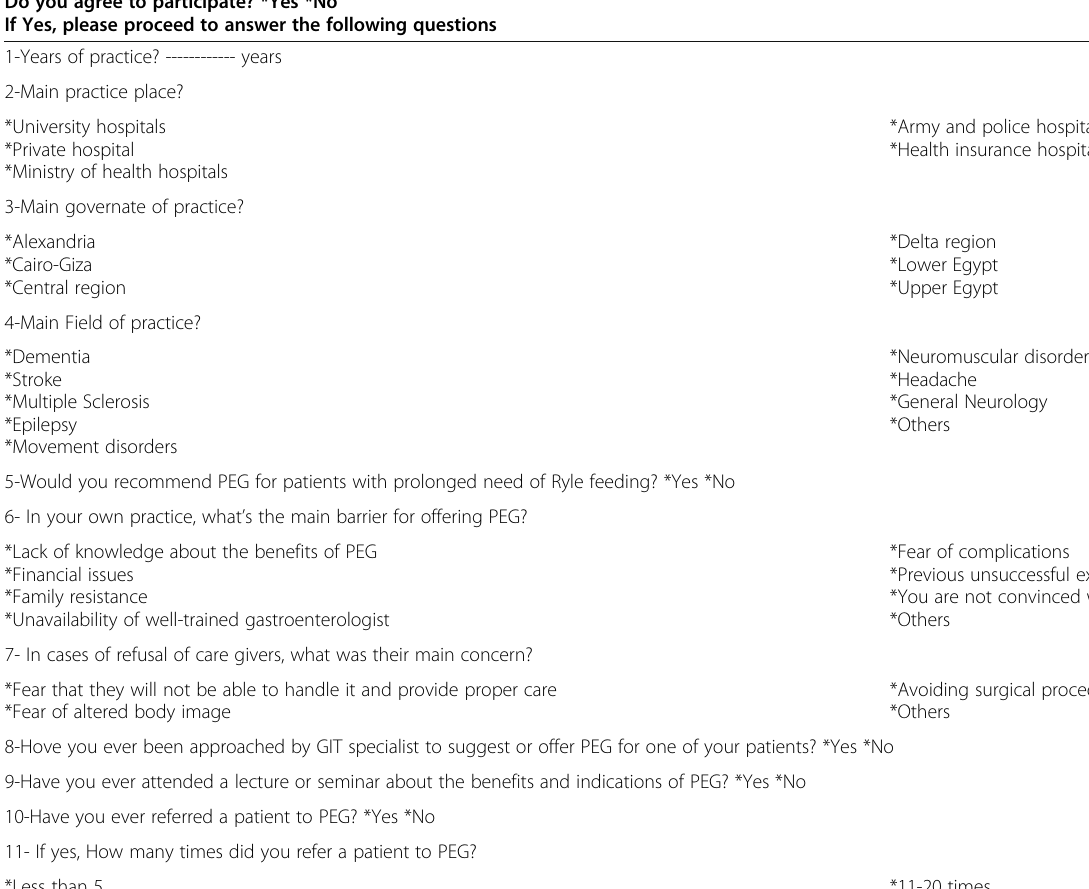
Table 1 Questionnaire regarding neurologists ’ experience regarding